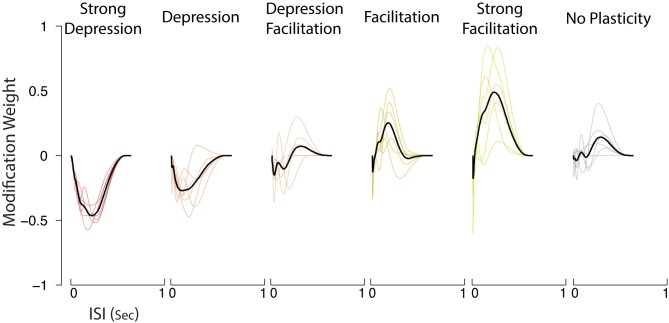
The modification function estimated using the generalized bilinear model (GBLM) for five different types of STP and for synapses with no plasticity.The modification functions for six strongest synapses (three inhibitory and three excitatory) are shown in color and the average is shown in black. These functions describe how synaptic weights change following different inter-spike intervals and allow the different types of STP to be distinguished. For strong depression, the modification function is negative and for strong facilitation the function is positive, capturing the respective decreases and increases in synaptic strengths.